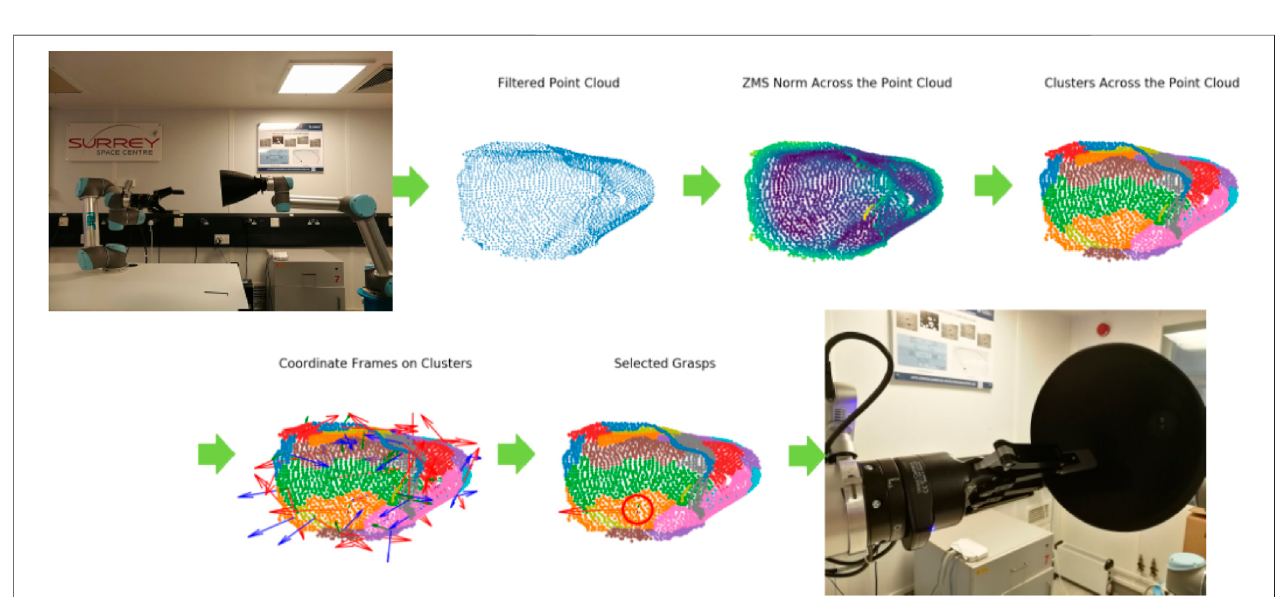
FIGURE4| Executionofthegraspingalgorithmonarobotictestbed,fora3Dprintednozzle,aspresentedbyMavrakisandGao(2019).Theintermediate stepsfor point cloud processing and grasp synthesis are shown.